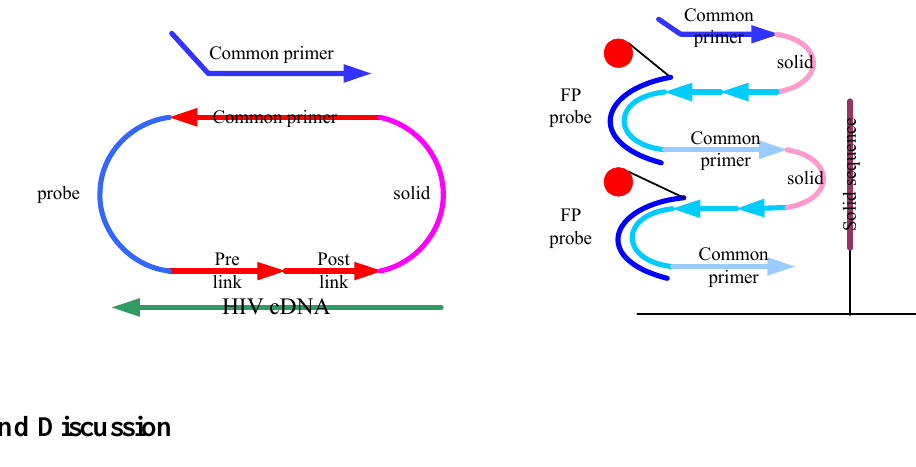
Figure 1. The RCA detection gene point mutation strategy: probe circularization by DNA ligase, and rolling circle amplification by phi29 DNA polymerase. The circularizable oligonucleotides probe was comprised of four regions: primer region, solid region, template region and probe region. The circularizable probe was initially introduced to detect a mutation in a target and closed the nick by incubating with a DNA ligase. Then binding complementary common primer, the circularized probe (C-probe) was amplified by phi29 DNA polymerase to generate multimeric single stranded DNA (ssDNA). The amplification products were hybridized with FPs(fluorescent probes) and solid probes that were immobilize to the surface of glass slide, and the fluorescent signals can be detected by